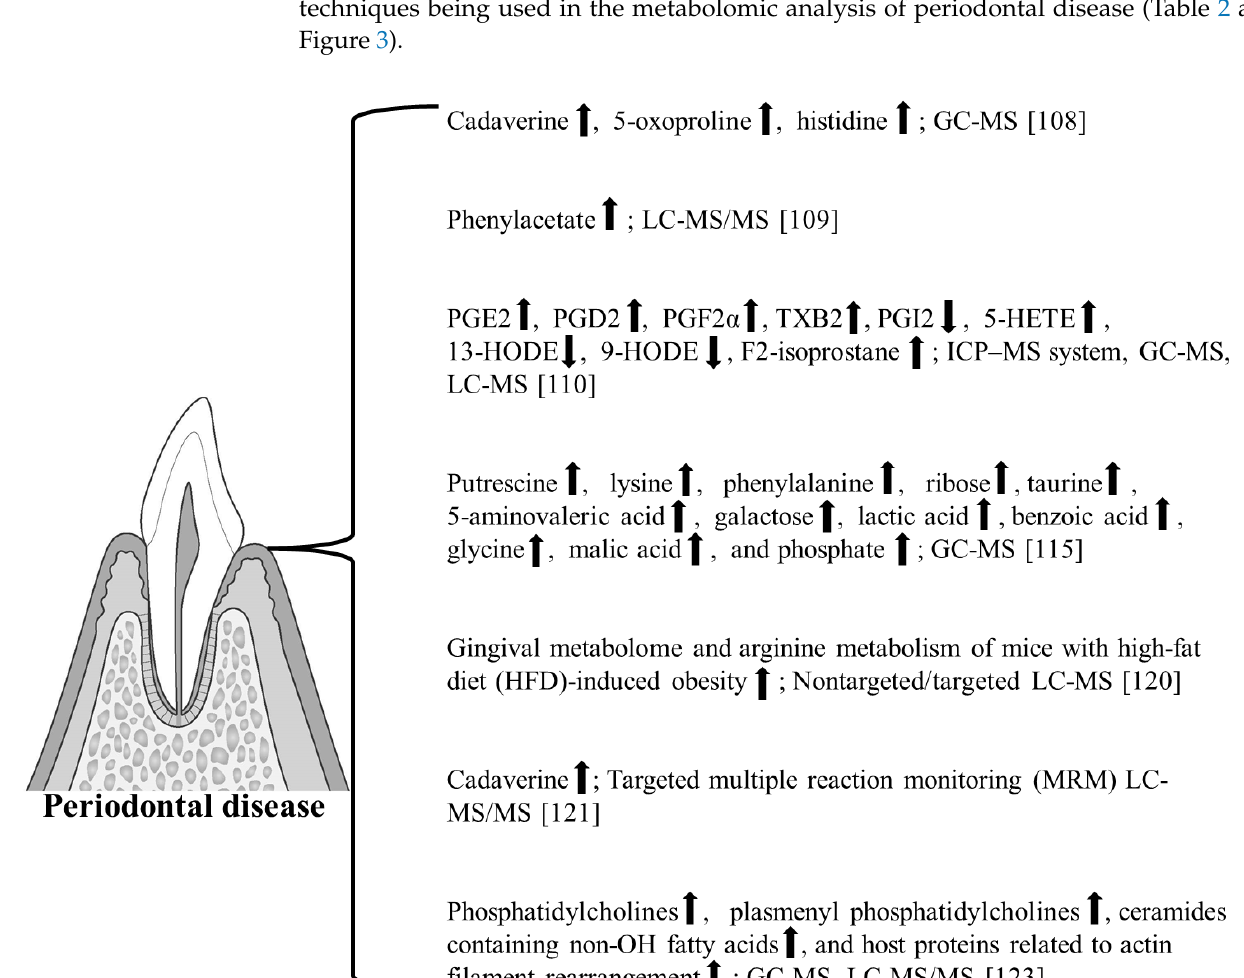
Figure 3. We suggest that the above are involved in periodontal disease. Summary of important findings of these studies.